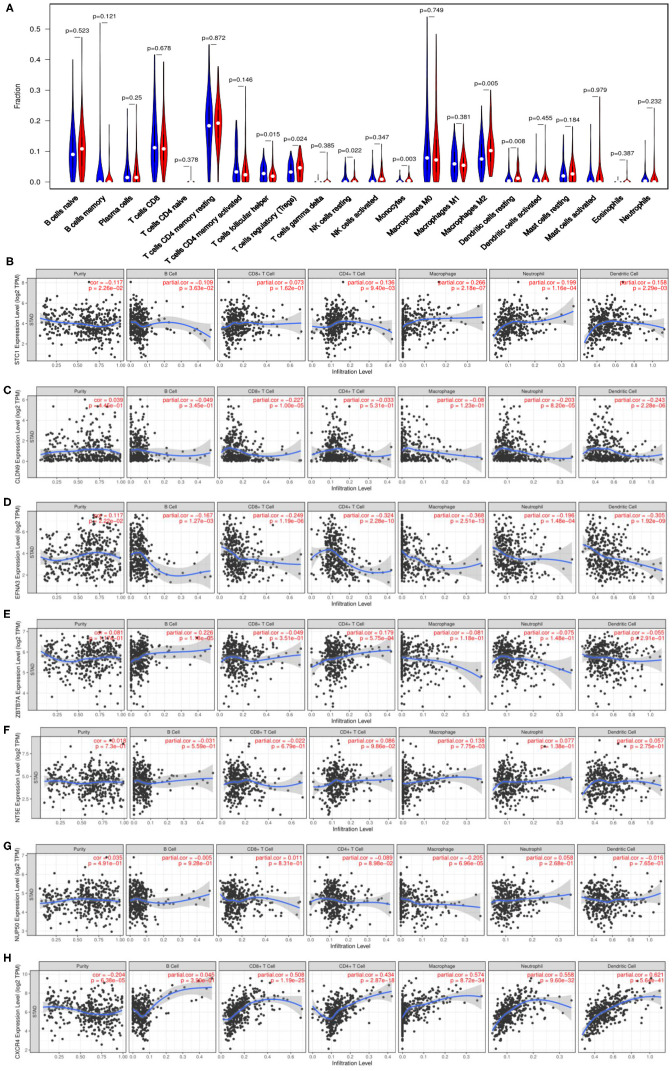
Correlation analysis of the expression of the seven GRGs with complex immune infiltration level in GC. (A) Violin plot analysis comparing the distribution of various immune cell infiltrations in the high- and low-risk groups. The red group represents the high-risk group, whereas the blue group represents the low-risk group. (B–H) Partial correlation analysis of the expression of the seven GRGs on tumor purity and immune infiltration levels by TIMER database. (B) STC1; (C) CLDN9; (D) EFNA3; (E) ZBTB7A; (F) NT5E; (G) NUP50; (H) CXCR4.